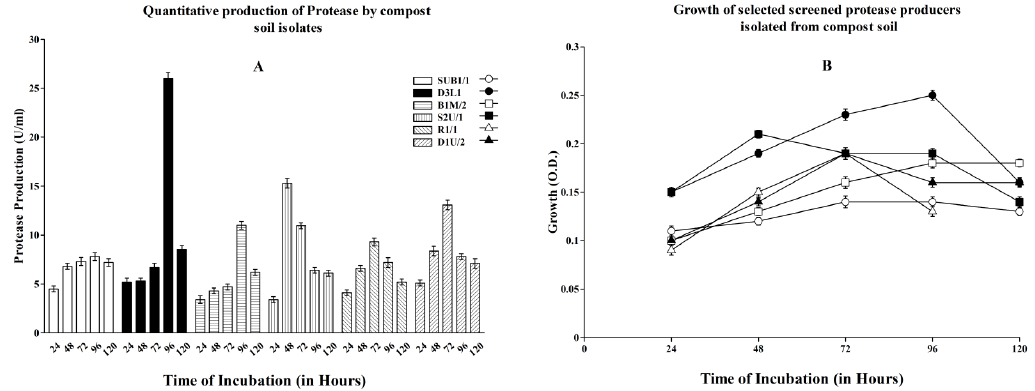
Figure 1. Effect of incubation period for extracellular protease production by selected screened isolates from compost soil. ( A ) Bar represents enzyme concentration (U/mL) and ( B ) line graph for bacterial growth (O.D.). The statistical significance was p < 0.05.